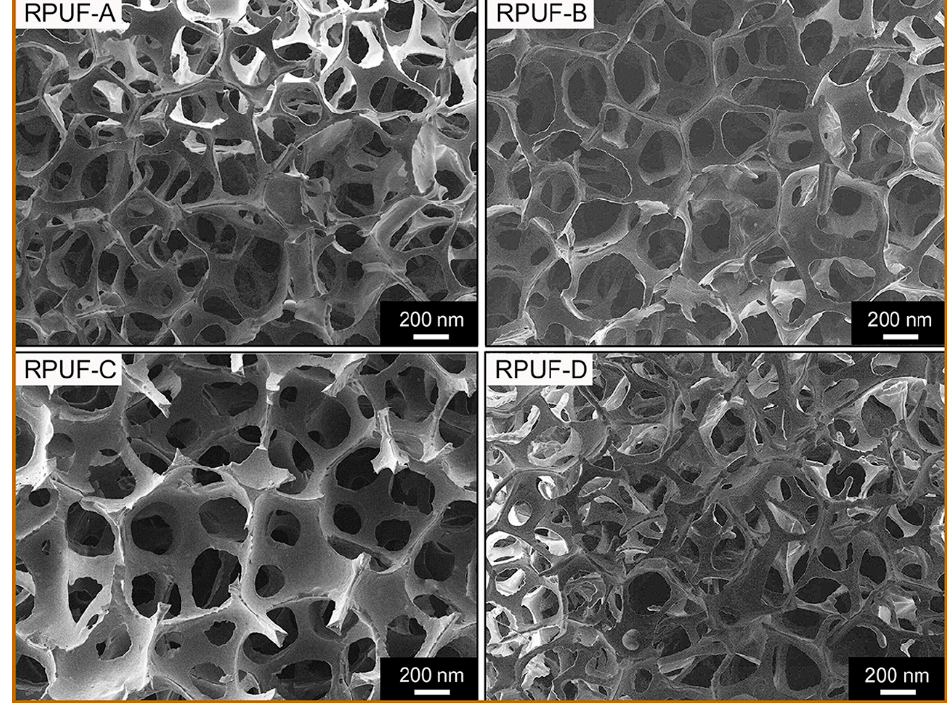
Figure 8. SEM images of the prepared RPUFs.